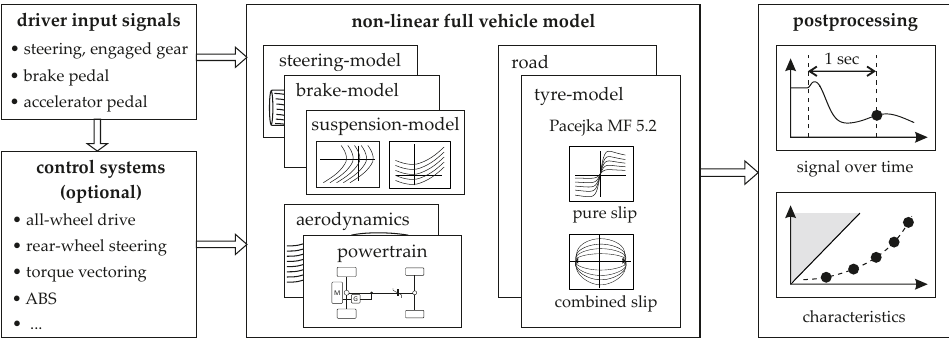
Figure 8. Sheme of the simulation environment with subsequent